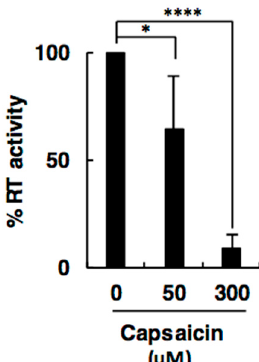
Figure 1. Capsaicin inhibits the activity of a retroviral reverse transcriptase (RT). The effect of capsaicin on activity of Moloney murine leukemia virus (M-MLV) RT was evaluated using an in vitro RT assay. Values are expressed as the means + S.E. of four independent experiments. * p < 0.05; **** p < 0.001.